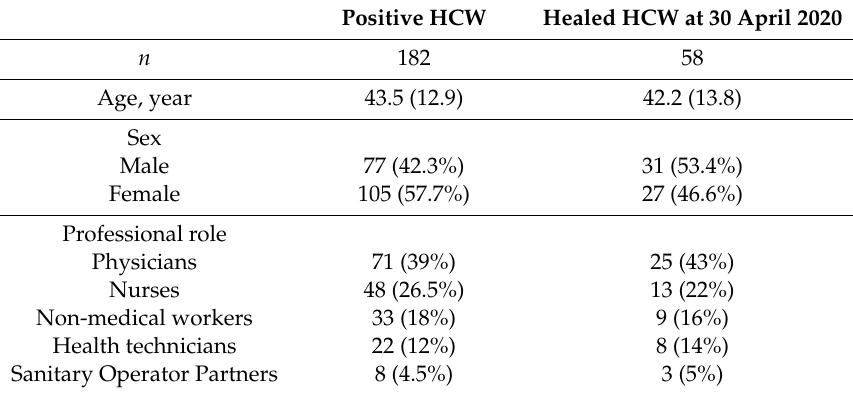
Table 1. Demographic characteristics of positive HCWs ( n = 182) and healed HCWs ( n = 58) who returned to work.